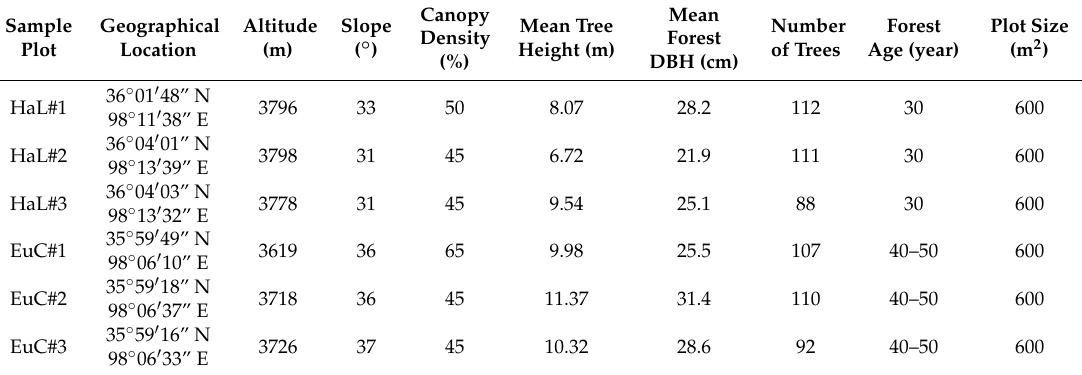
Table 1. Geographical and plant community characteristics in Sabina przewalskii Kom.